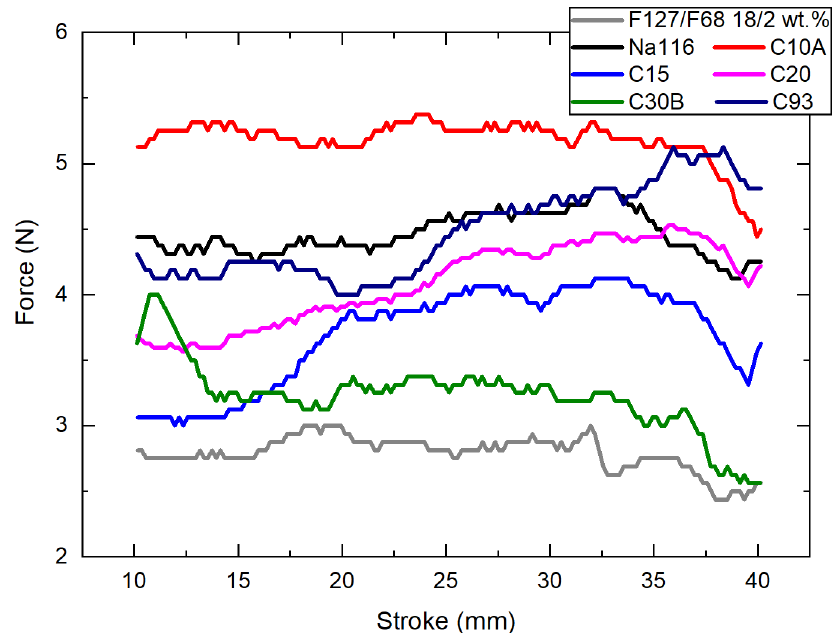
Figure 7. Injectability force required for all Pluronic–clay composites, with a clay concentration at 2 wt.% to be injected from a 3 mL syringe at 4 mm/s at 25 °C.